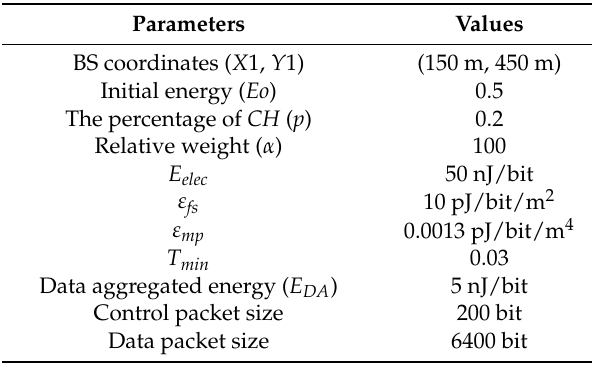
Figure 8. The experimental environment. Table 1. The common simulation parameters.